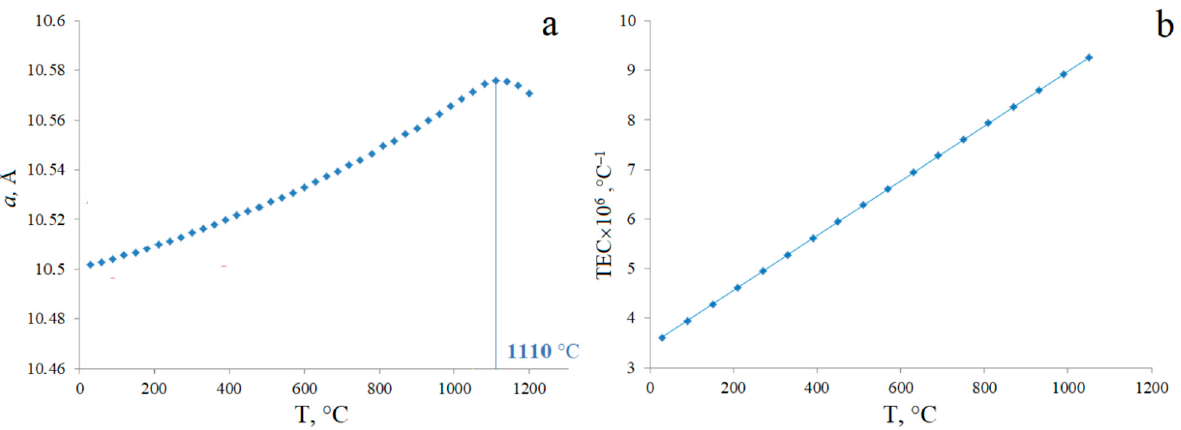
Figure 5. Temperature dependences of unit cell parameter ( a ) and TECs ( b ) of the Bi 2 Mg 0.5 Fe 0.5 Ta 2 O 9.5- Δ . Fe 0.5 Ta 2 O 9.5 − ∆